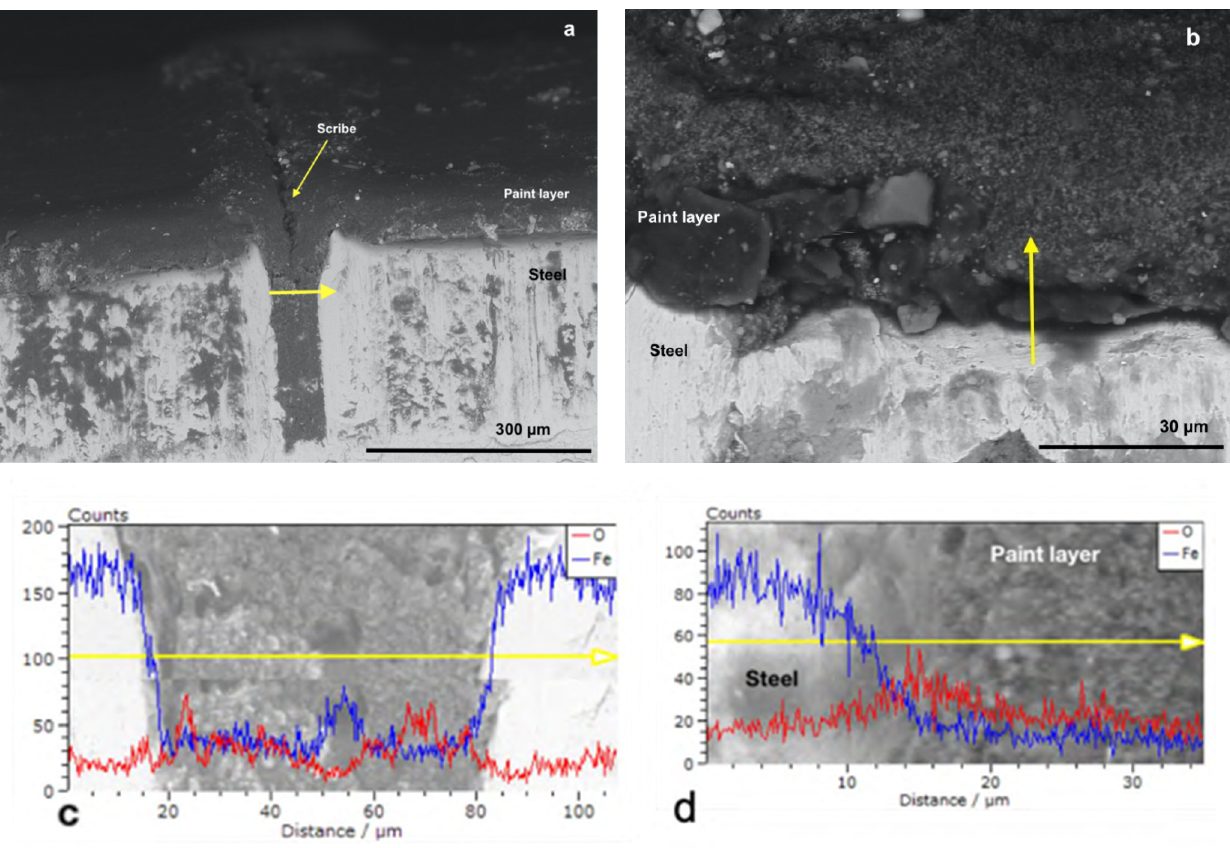
Figure 4. SEM micrographs with EDX linescan ( c , d ) of the cross-section of P_MB U coated specimens at ( a ) the scribe and at ( b ) no-scribed region. Red and blue spectra correspond to O and Fe, respectively.